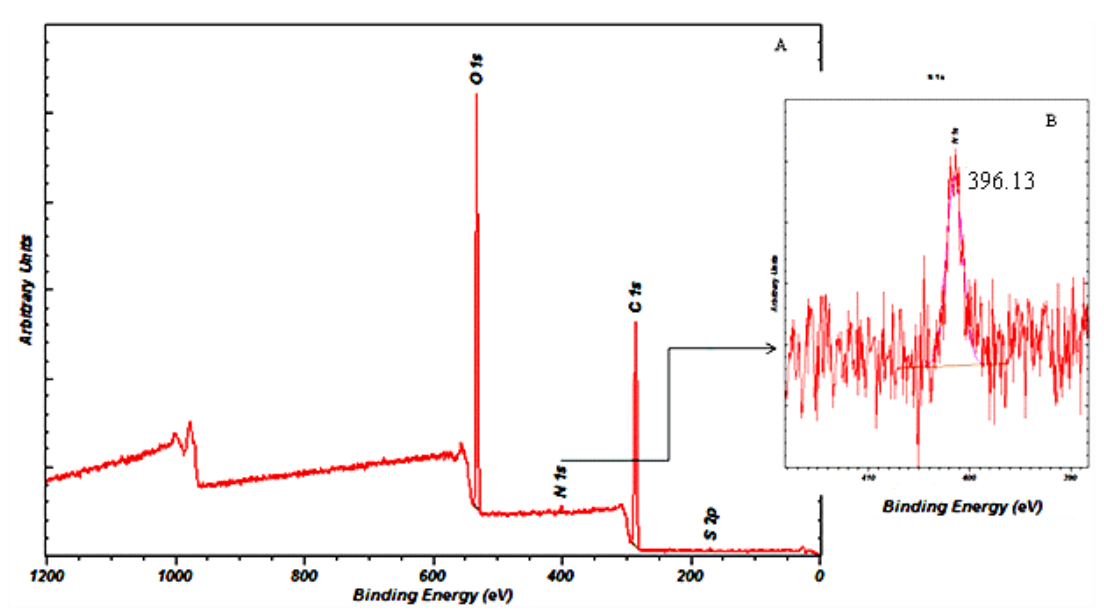
( B ) Magnification of the nitrogen peak with a binding energy of 396.13